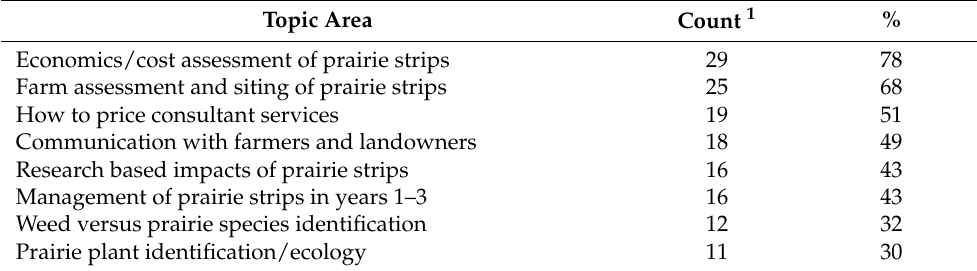
Table 4. End-of-session check-all-that-apply items. With which topics would benefit from additional practice or support?